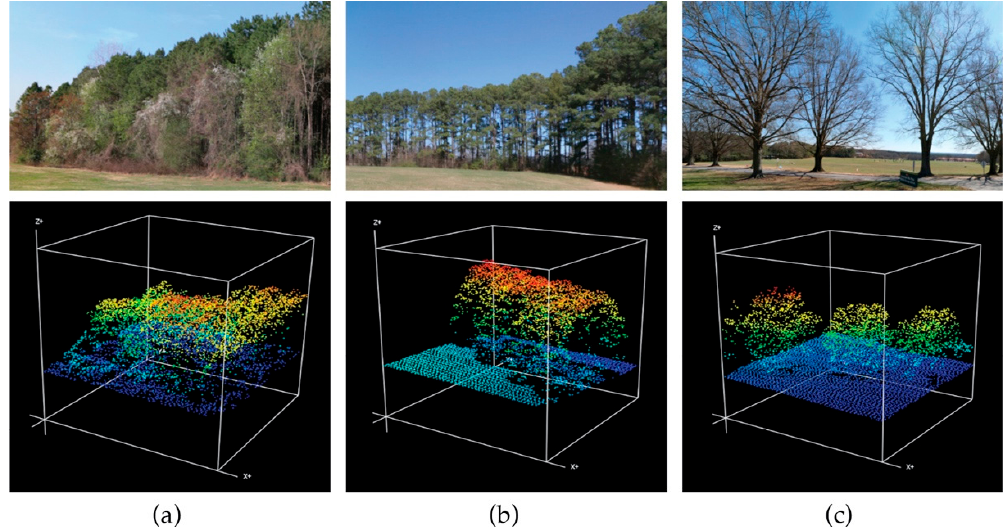
Figure 4. Field images (top) and lidar points (bottom) showing three vegetation structures: ( a ) Evergreen over-story mixed with deciduous midstory and understory; ( b ) dense evergreen patches and understory; ( c ) dispersed deciduous species.